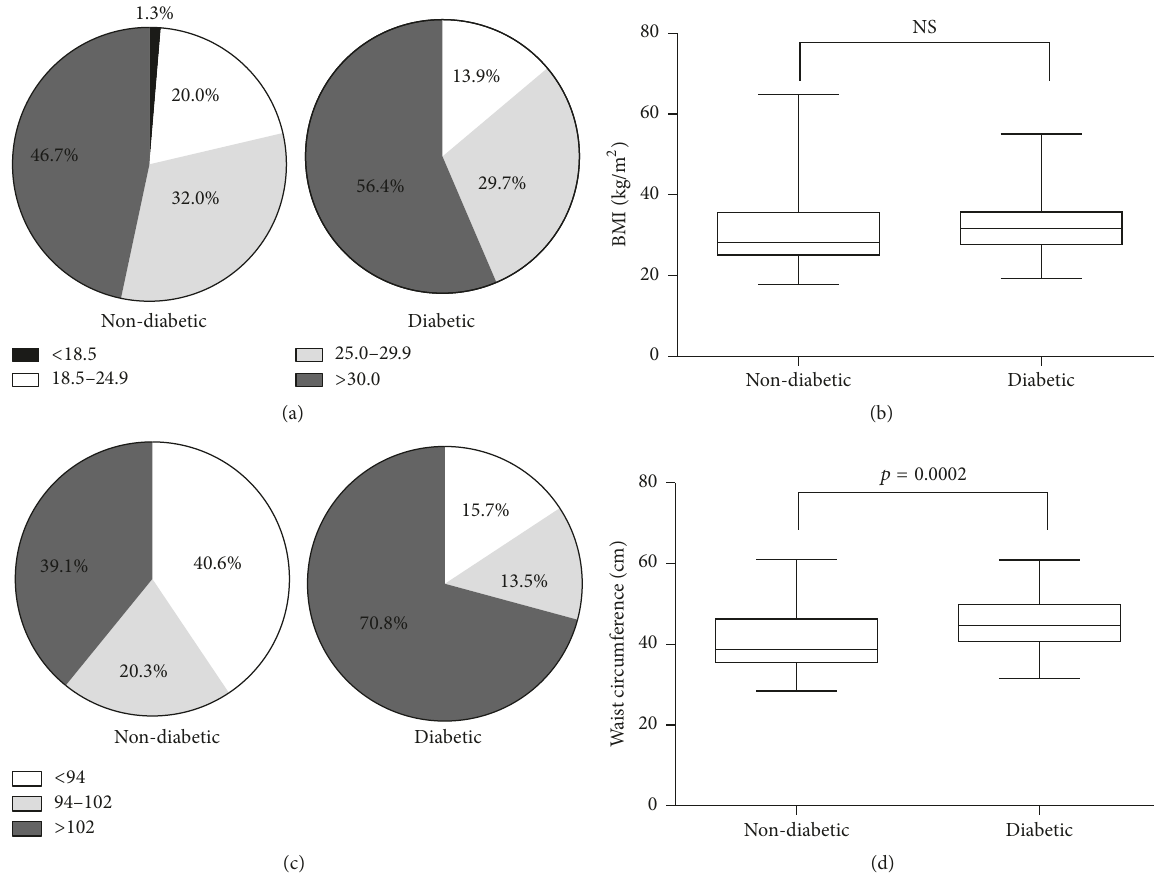
Figure 1: Anthropometric data related to the metabolic syndrome. (a) BMI distribution in nondiabetic and diabetic groups showing the proportion of underweight (BMI < 18.5 kg/m 2 ), normal weight (18.5 kg/m 2 ≤ BMI ≤ 24.9 kg/m 2 ), overweight (25.0 kg/m 2 ≤ BMI ≤ 29.9 kg/m 2 ), and obese (30.0 kg/m 2 ≤ BMI) in nondiabetic (𝑛 = 75) and diabetic (𝑛 = 85) groups. (b) Box plots of BMI for nondiabetic and diabetic groups. The upper and lower whiskers indicate the maximum and minimum values. The upper and lower borders of the box indicate the 25th and the 75th percentile, respectively. The black line in each box indicates the median. (c) Waist circumference (WC) distribution in nondiabetic and diabetic groups showing the proportion of normal waist circumference (WC < 94 cm), increased health risk (94cm ≤ WC ≤ 102 cm), and substantial health risk (102cm < WC) in nondiabetic (𝑛 = 69) and diabetic (𝑛 = 85) groups. (d) Box plots of WC for nondiabetic and diabetic groups. The upper and lower whiskers indicate the maximum and minimum values, respectively. The upper and lower borders of the box indicate the 25th and the 75th percentile, respectively. The black line in each box indicates the median. NS indicates no significant